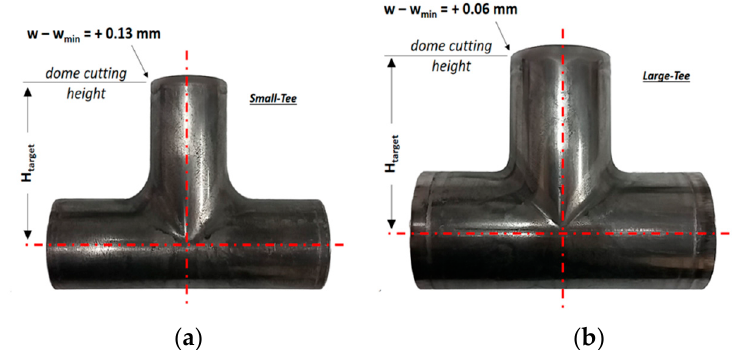
Figure 9. Hydroformed T-joints fabricated using the optimized process curves. ( a ) Small-Tee and ( b ) Large-Tee pieces. Large-Tee